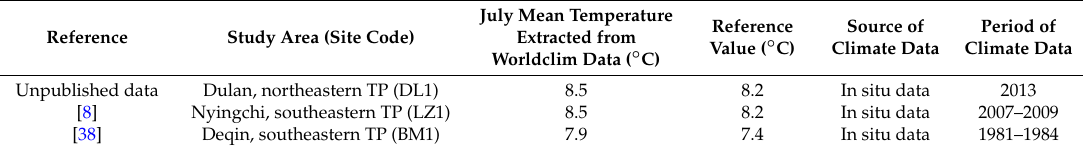
Table 2. Comparison between the July mean temperatures extracted from the Worldclim global climate dataset (see more details in [25]) and the reference values obtained from in situ climatic observations. Sites’ characteristics are described with more detail in the references (first